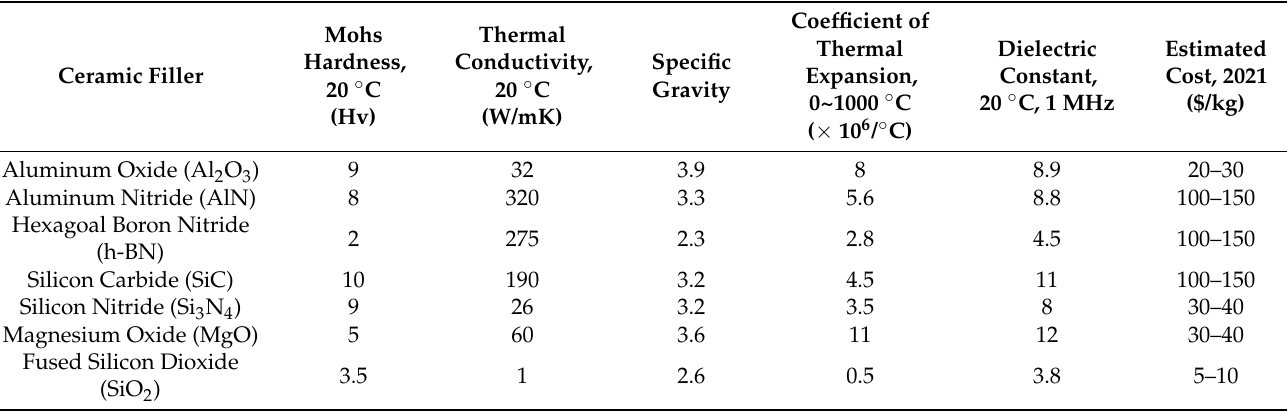
Table 1. Comparison of intrinsic properties and estimated cost of commercial ceramic